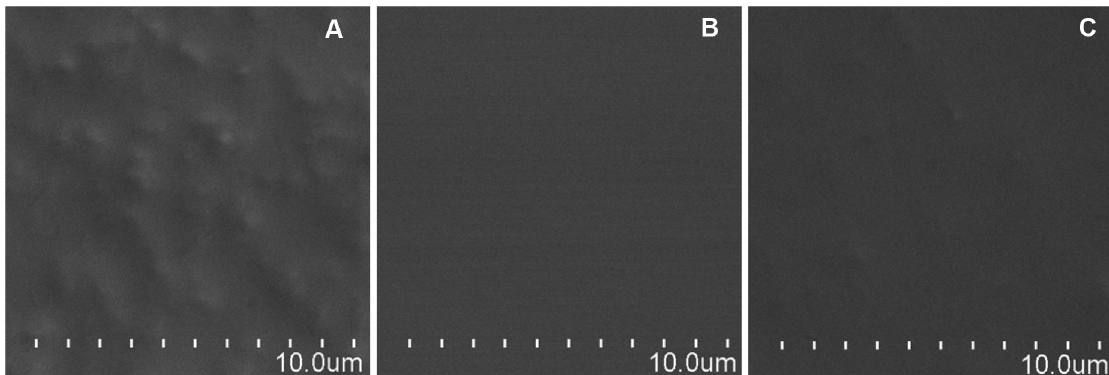
FIGURE 4 - SEM images of the surfaces of gelatin (A); chitosan (B) and gelatin/chitosan (C) films.